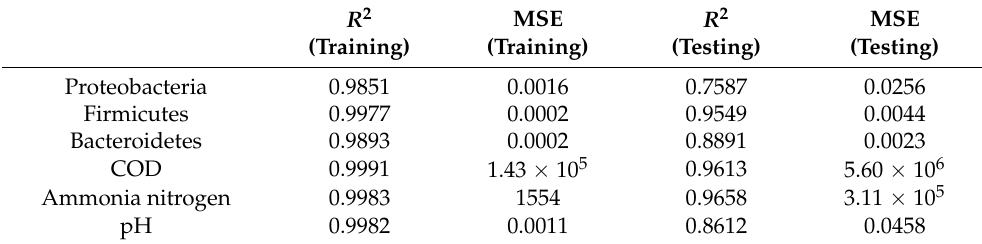
Table 9. Comparison of the GBDT prediction models based on the original e-nose dataset.